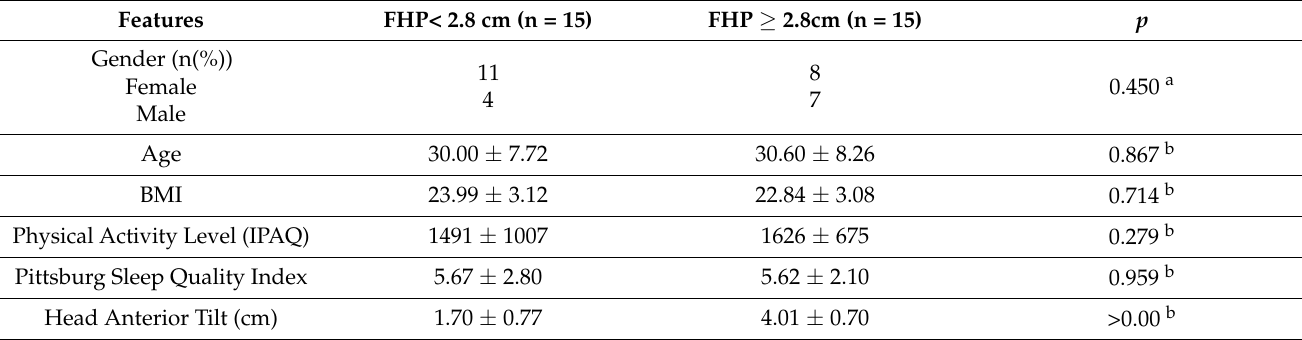
Table 2. Demographic, physical, and psychosocial characteristics of individuals with